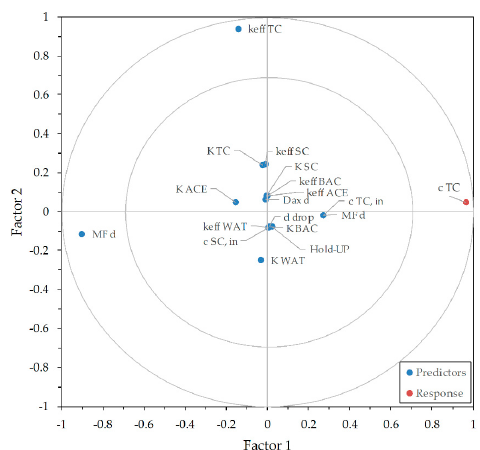
Figure 9. Partial-least-squares analysis of the model parameters used in the multi-parameter-at-a-time sensitivity study. MF (mass flow), K (distribution coefficient), k eff (effective mass transfer coefficient), Dax (axial dispersion coefficient), d (diameter), TC (target component), SC (side component), ACE (acetone), BAC (butyl acetate), WAT (water).